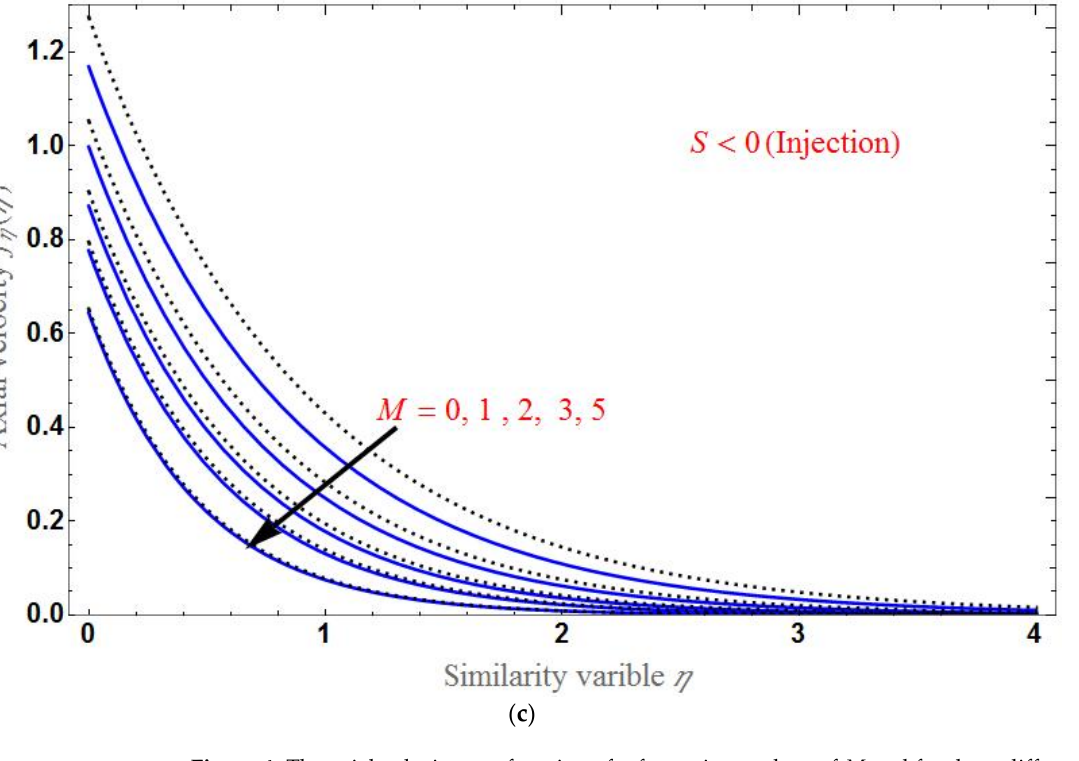
Figure 4. The axial velocity as a function of η for various values of M and for three different regimes of S : ( a ) S = 0, ( b ) S = 1 and ( c ) S = − 1. The other fixed parameters are: Λ = Da − 1 = 1, φ 1 = 0.1, φ 2 = 0.04.